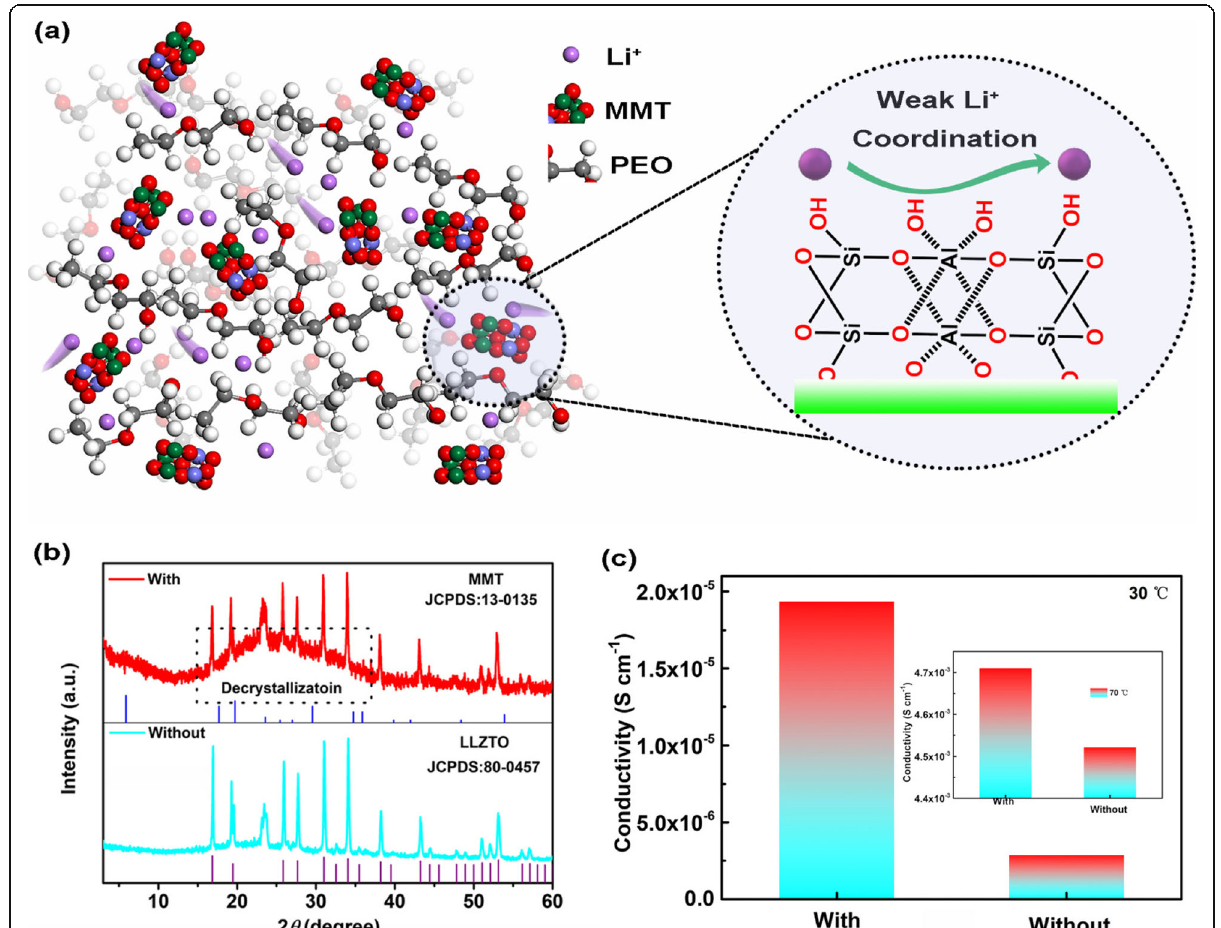
Fig. 1 Characterization of SPEs with montmorillonite doping: a The design concept that lithium ion can fast diffusion along the surface of montmorillonite. b , c The XRD and FTIR results of SPEs with or without montmorillonite particles,